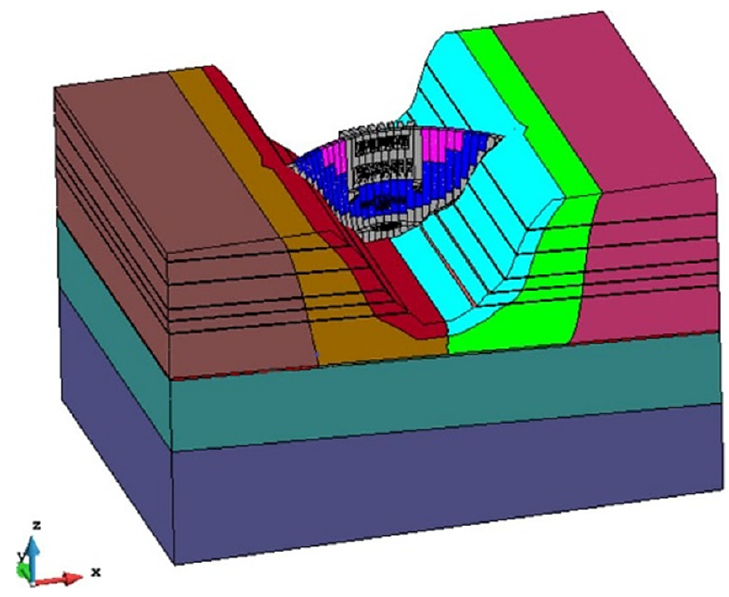
Figure 6. Overall finite element model of dam body-foundation.